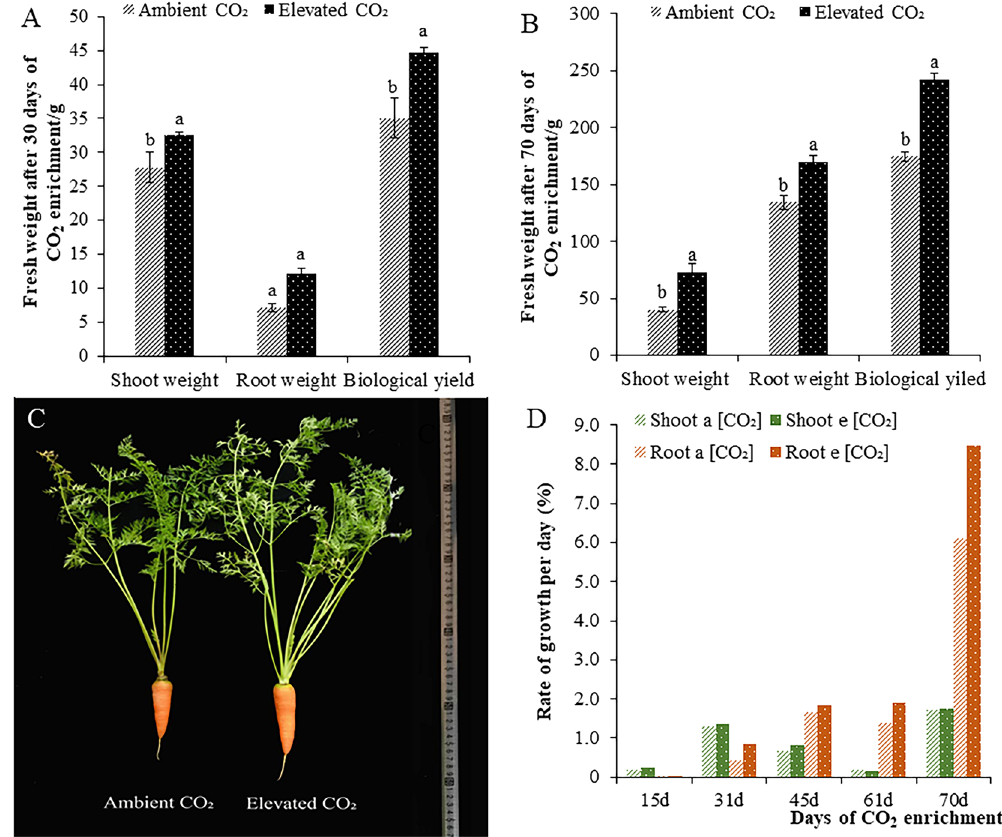
Figure 1. The effect of CO 2 enrichment on the weight and growth rate of stems and roots. Biomass was measured 15, 31, 45, 61, and 70 days following the application of CO 2 . (C) 70 d after CO 2 application. Capital letters in each figure and table represent extremely significant differences among samples by Student’s t-test ( P < 0.01) and small letters represent significant differences ( P < 0.05). Labels in the figures and tables below are the